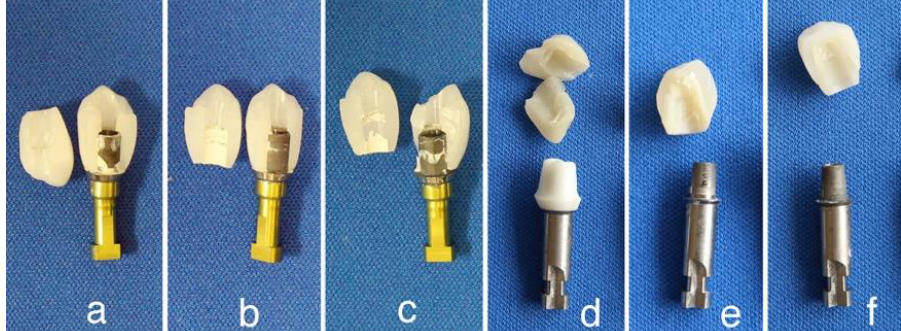
Figure 17. Photographs of fracture specimens for the superstructure of monolithic zirconia crown